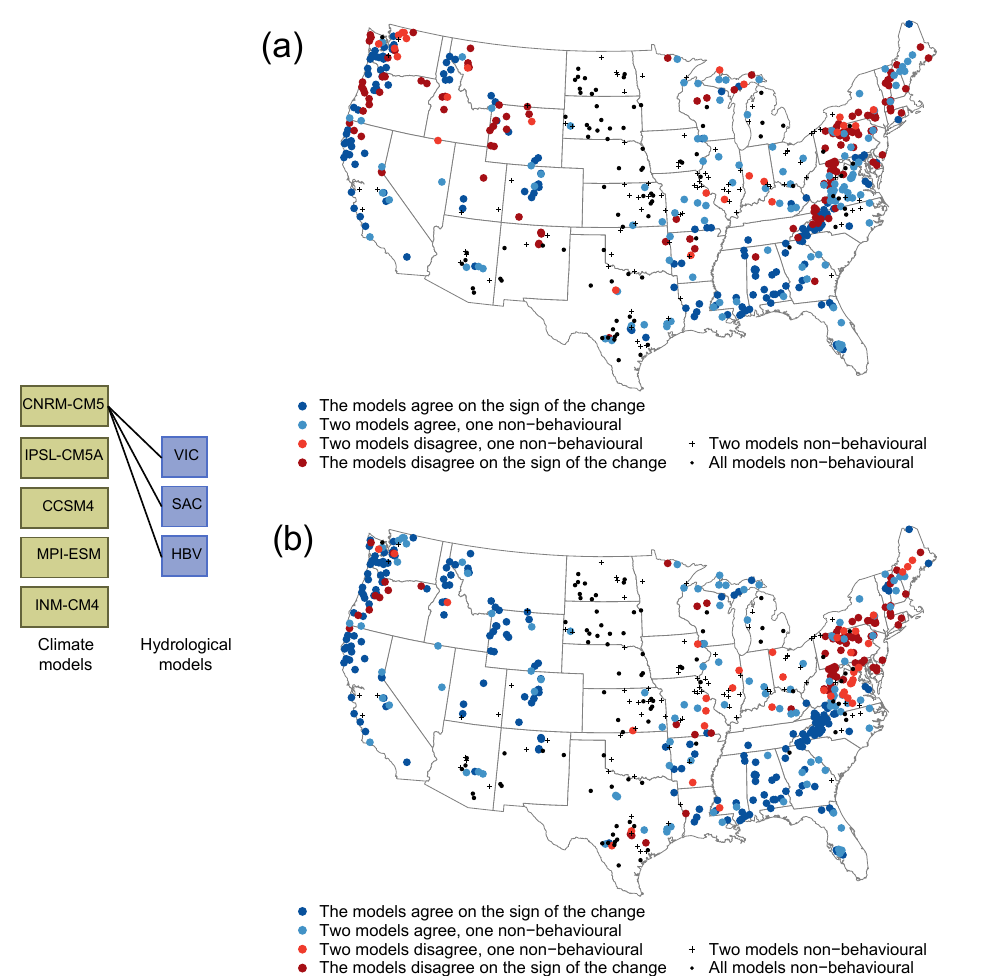
Figure 3. Distribution of uncertainty in the sign of change in mean runoff (a) and discharge timing (b) over the contiguous US when three hydrological models are compared. Left panel: combination of climate model and hydrologic model for which the results are displayed. VIC: Variable Infiltration Capacity model; SAC: Sacramento Soil Moisture Accounting model; HBV: Hydrologiska Byråns Vattenbalansavdelning model. (a) Agreement among the three different hydrologic models (all forced with CNRM-CM5) on the sign of the ensemble mean change in mean annual runoff. (b) Agreement among the three different hydrologic models (all forced with CNRM-CM5) on the sign of the ensemble mean change in discharge